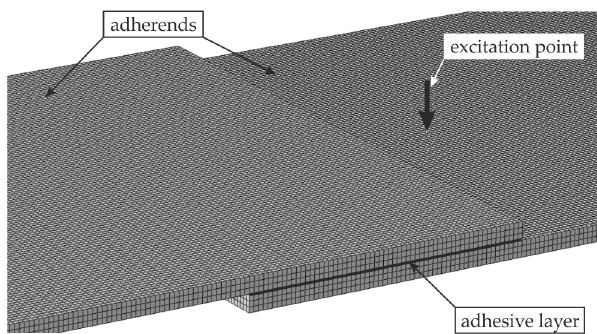
Figure 5. View of a discretized model for numerical calculations with an indicated excitation point.